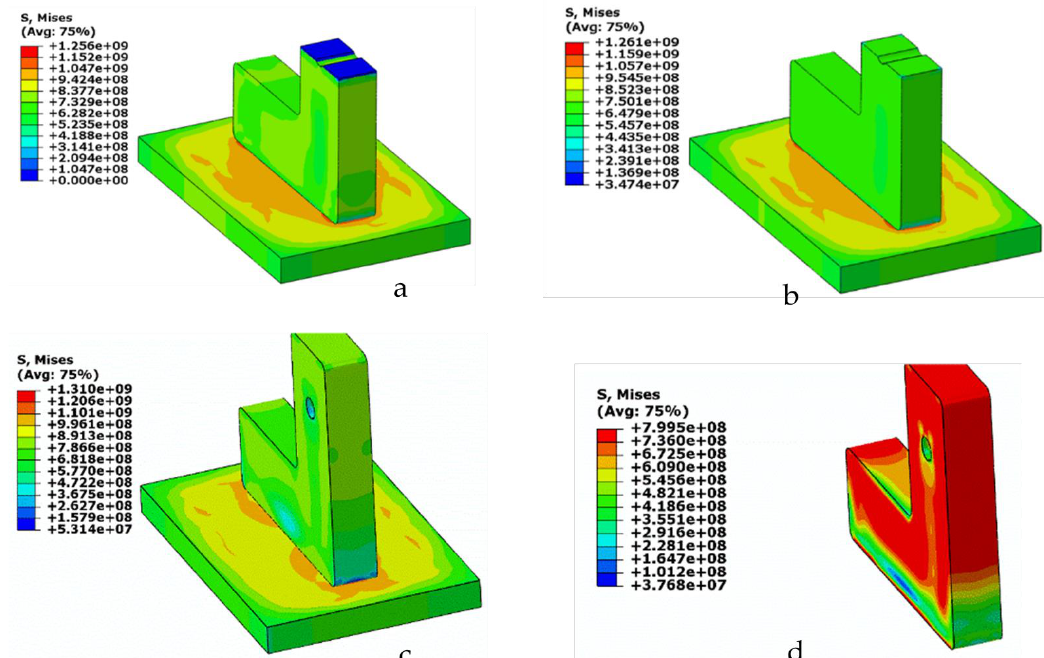
Figure 8. von Mises stress distribution in Pa for VB at various stages while printing ( a ) when a new layer is activated, ( b ) just before a new layer is added, ( c ) when the entire part is cooled down with base plate, and ( d ) when base plate is removed. (Note: stresses are in Pa scale.)